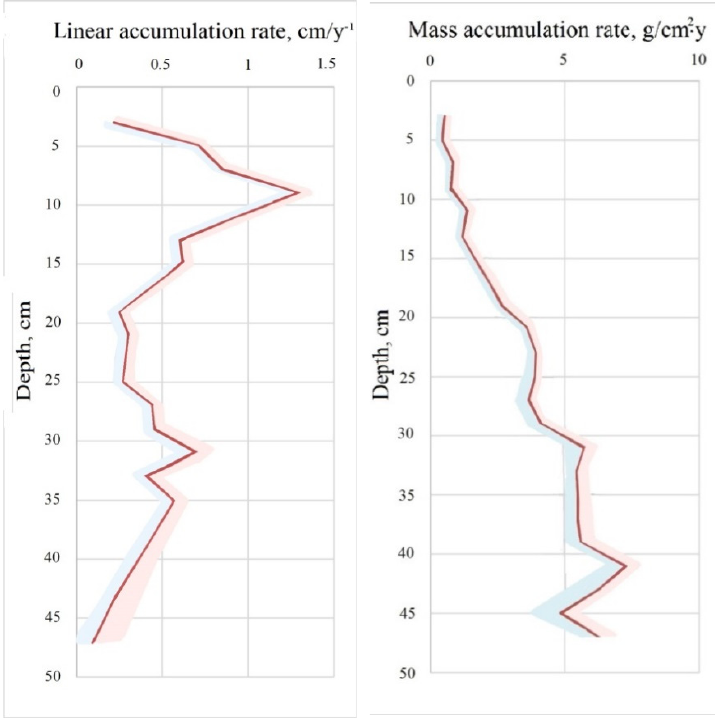
Figure 6. Linear accumulation rate s and mass accumulation rate r along the depth of the peat profile.